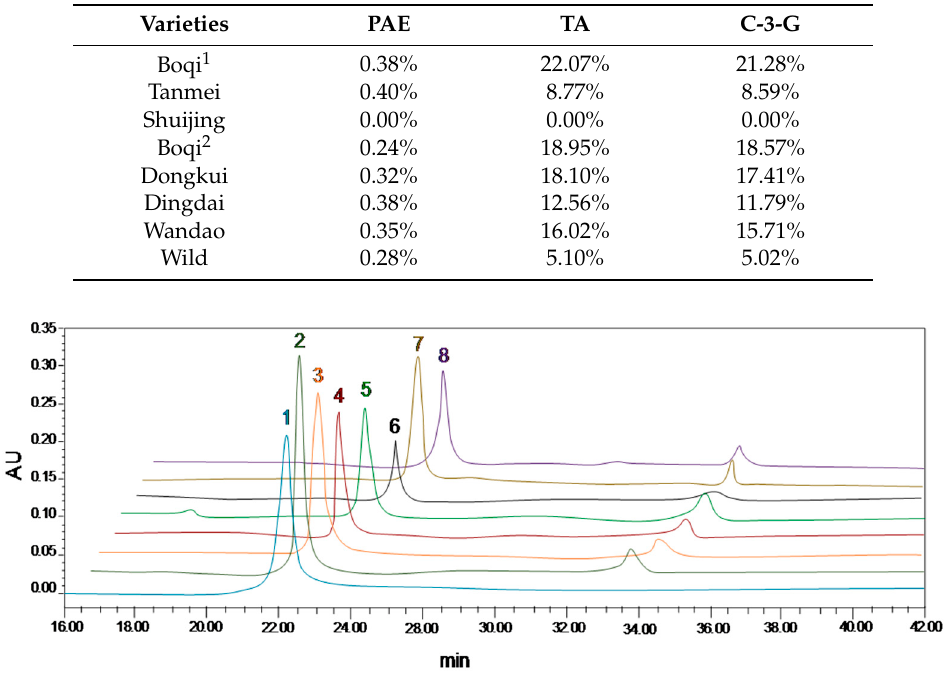
Table 1. The levels of purified anthocyanin extracts (PAEs), and the total anthocyanin (TA) and